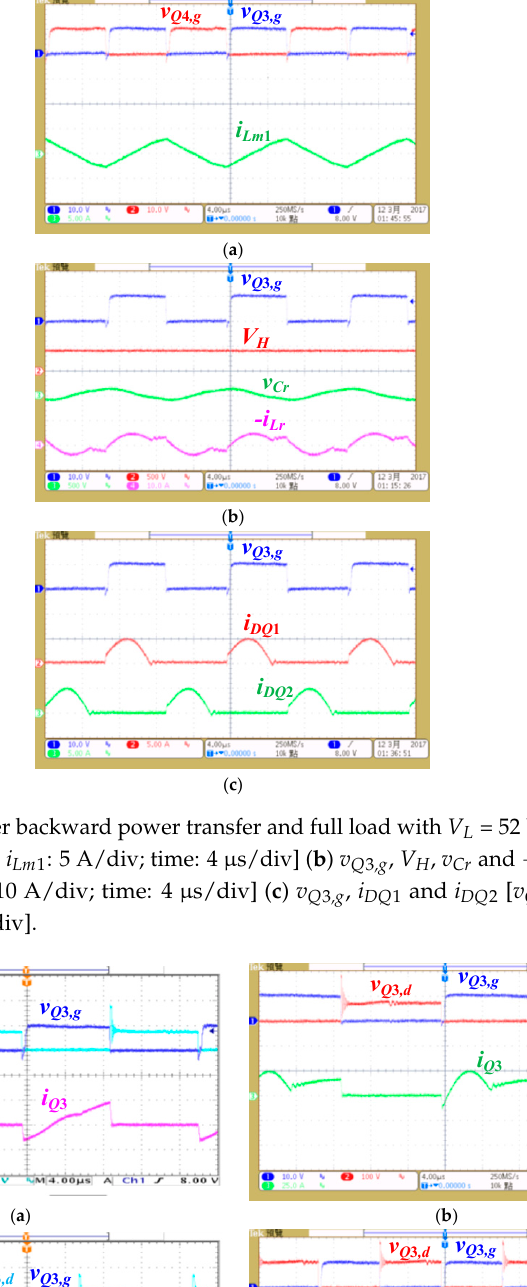
Figure 11. Test results under backward power transfer and full load with V L = 38 V ( a ) v Q 3 ,g , v Q 4 ,g and i Lm 1 [ v Q 3 , g , v Q 4 , g : 10 V/div; i Lm 1 : 5 A/div; time: 4 µs/div] ( b ) v Q3,g , V H , v Cr and − i Lr [ v Q 3 ,g : 10 V/div; V H , v Cr : 500 V/div; − i Lr : 10 A/div; time: 4 µs/div] ( c ) v Q 3 ,g , i DQ 1 and i DQ 2 [ v Q 3 ,g : 10 V/div; i DQ 1 , i DQ 2 : 5 A/div; time: 4 µs/div].